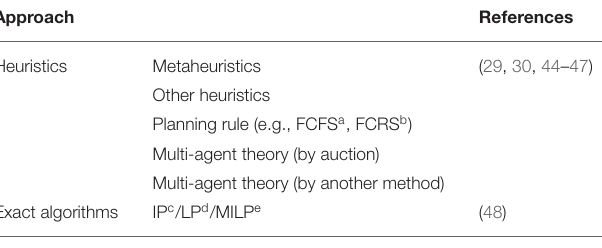
TABLE 4 | Taxonomy rely on the planning methods. Different Planning